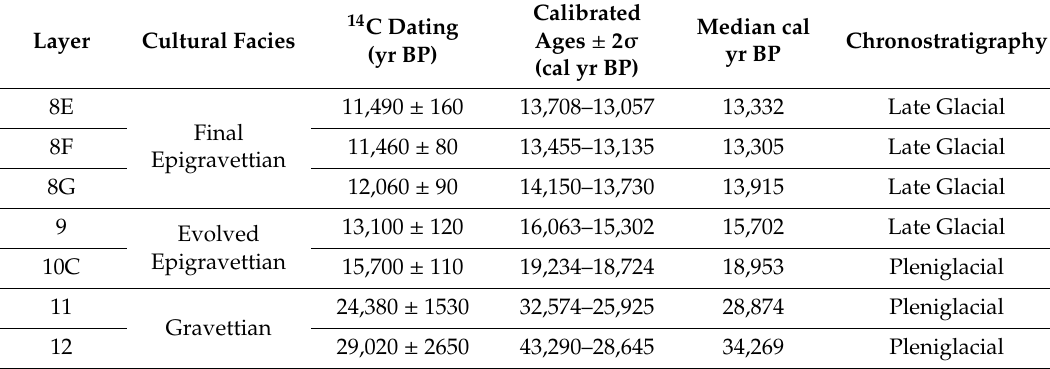
Table 1. Age and cultural facies of Serratura Cave layers (SW Italy). Conventional 14 C ages were calibrated using the OxCal v. 4.3 program (Bronk Ramsey, 2009) and the IntCal3 calibration curve data (Reimer et al., 2013). Calibrated calendar years before present (cal BP) expressed as either a two-sigma probability age range and a median probability